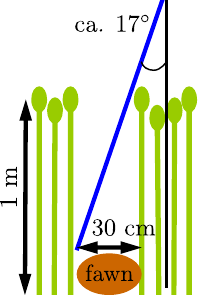
Figure 2: geometric boundary conditions